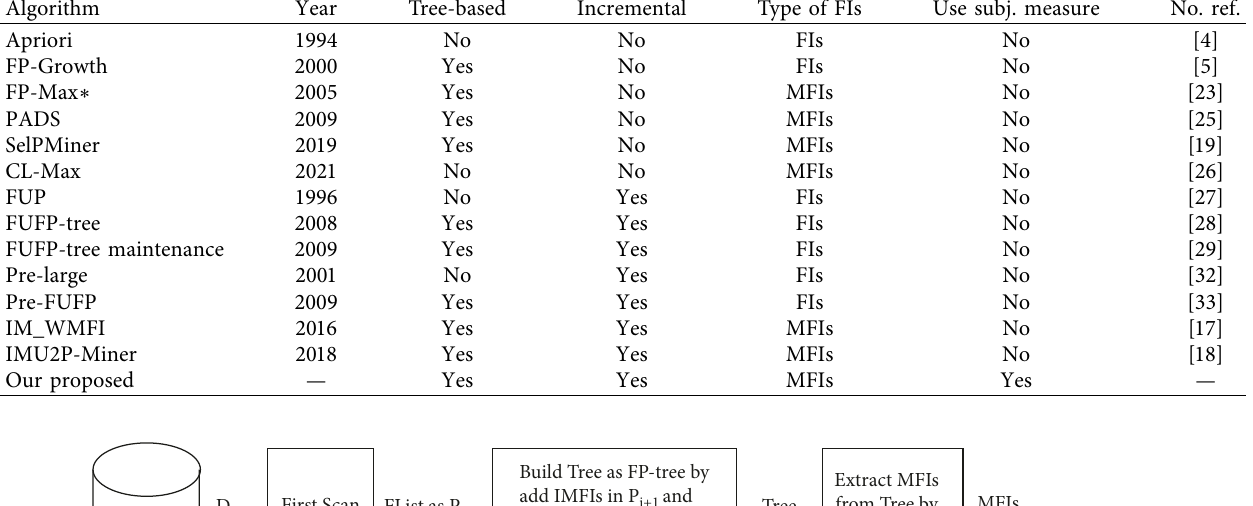
Table 1: Characteristics of the major algorithms reviewed.